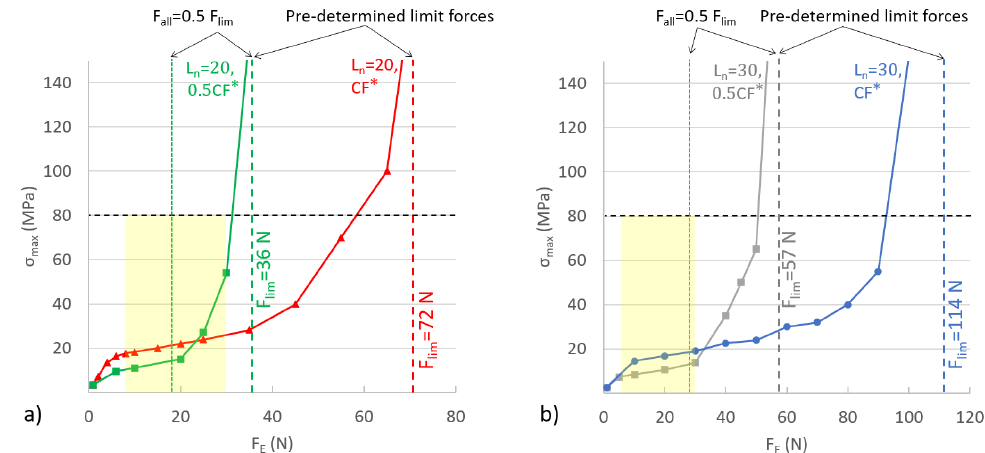
Figure 11. Blade B. Maximum “nominal” bending stress vs. F E for : ( a ) the shorter neck L n = 20 mm, full and half CF values; ( b ) the longer neck L n = 30 mm, full and half CF values. Shaded areas represent the maximum assumed span of the proof excitation force F E . The horizontal dashed line represents the allowable nominal bending stress σ a , bend